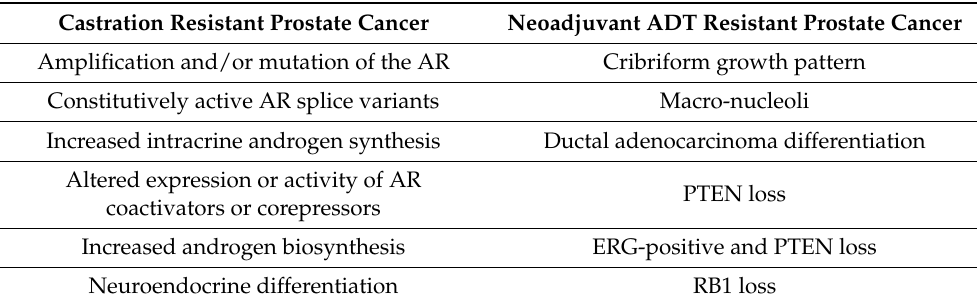
Table 1. Summary of the Unique Mechanisms and Characteristics of Disease. Castration Resistant Prostate